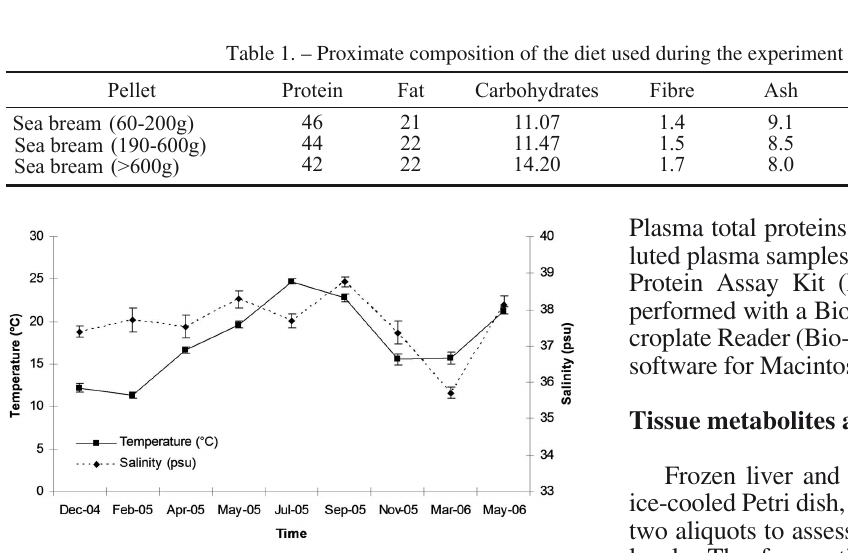
Fig. 1. – Average values for water temperature (°C) and salinity (‰) during the experimental period. Data are shown as mean±SEM. Each factor was measured daily; the average is for number of days between